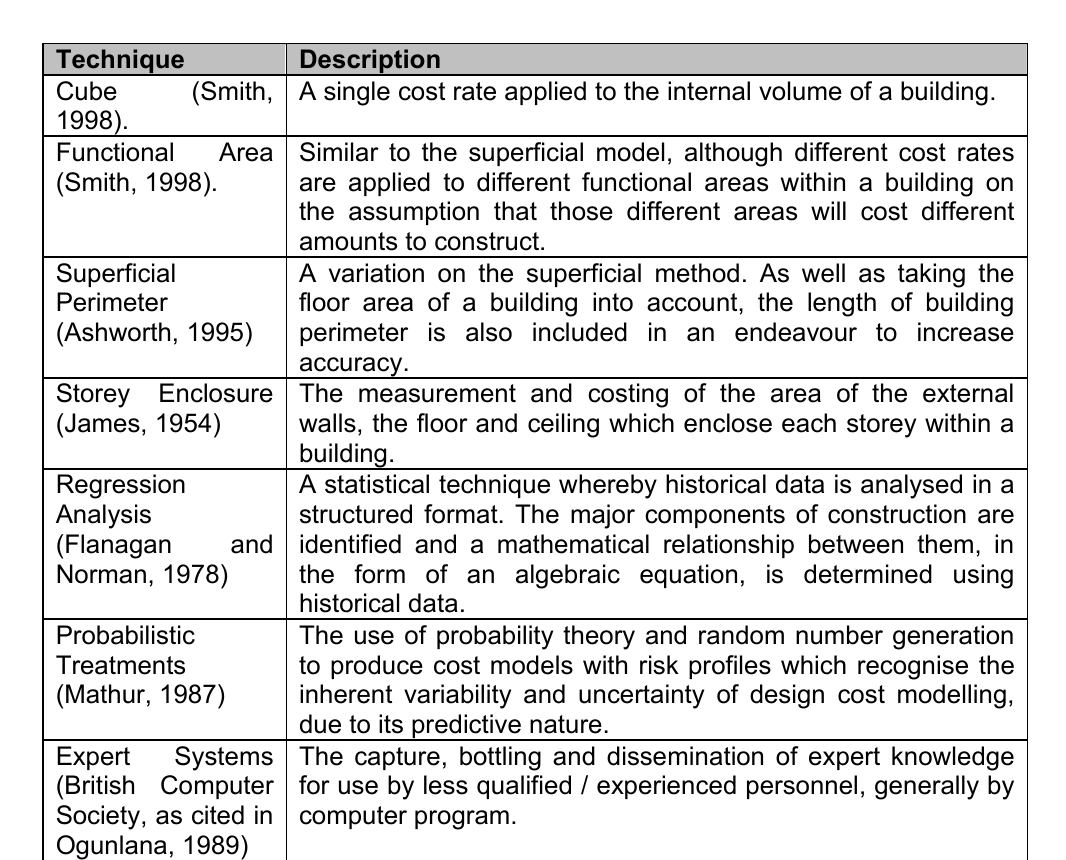
Table 2 – Lesser used product based cost modelling